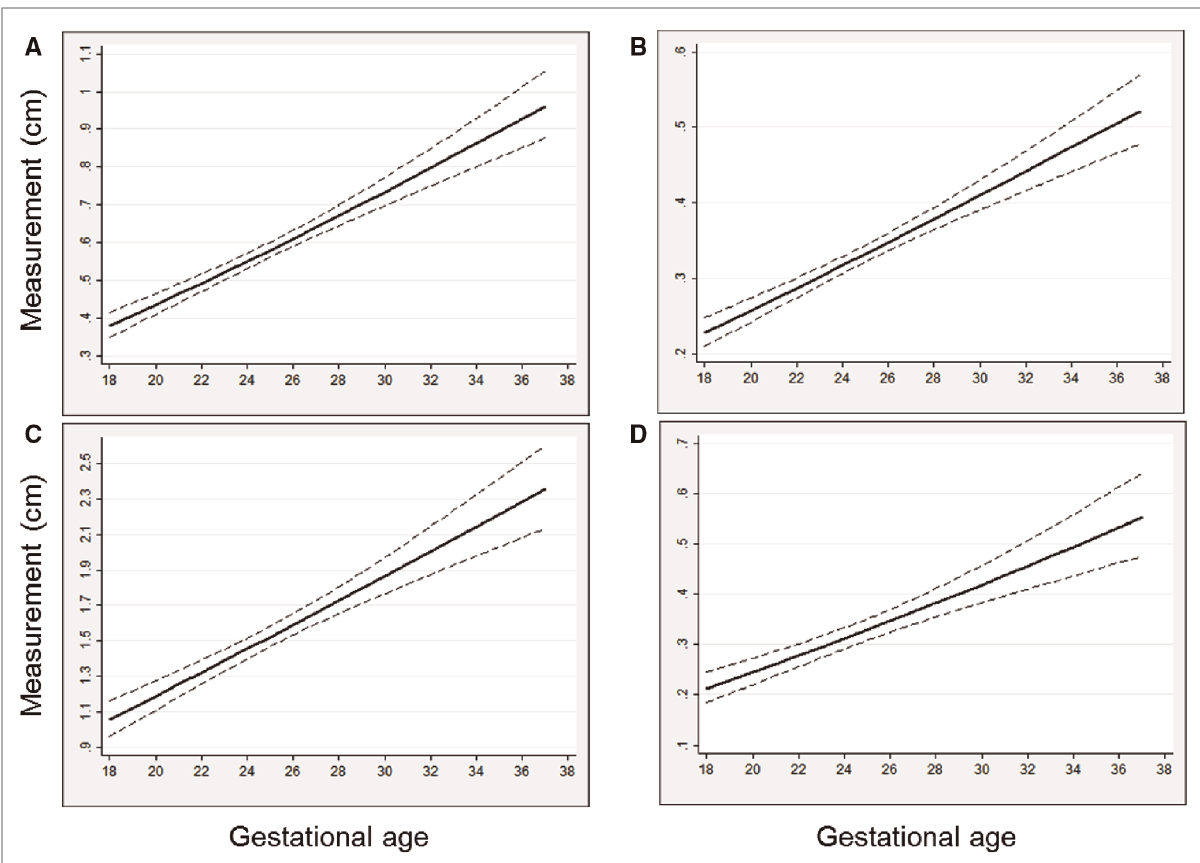
FIGURE 2 Predicted left heart structure size versus gestational age from left CDH-speci fi c models, with regression line and 95% con fi dence interval shown, ( A ) mitral valve diameter; ( B ) aortic valve diameter; ( C ) left ventricle length; ( D ) left ventricle width. Predicted values are back-transformed from natural log models.